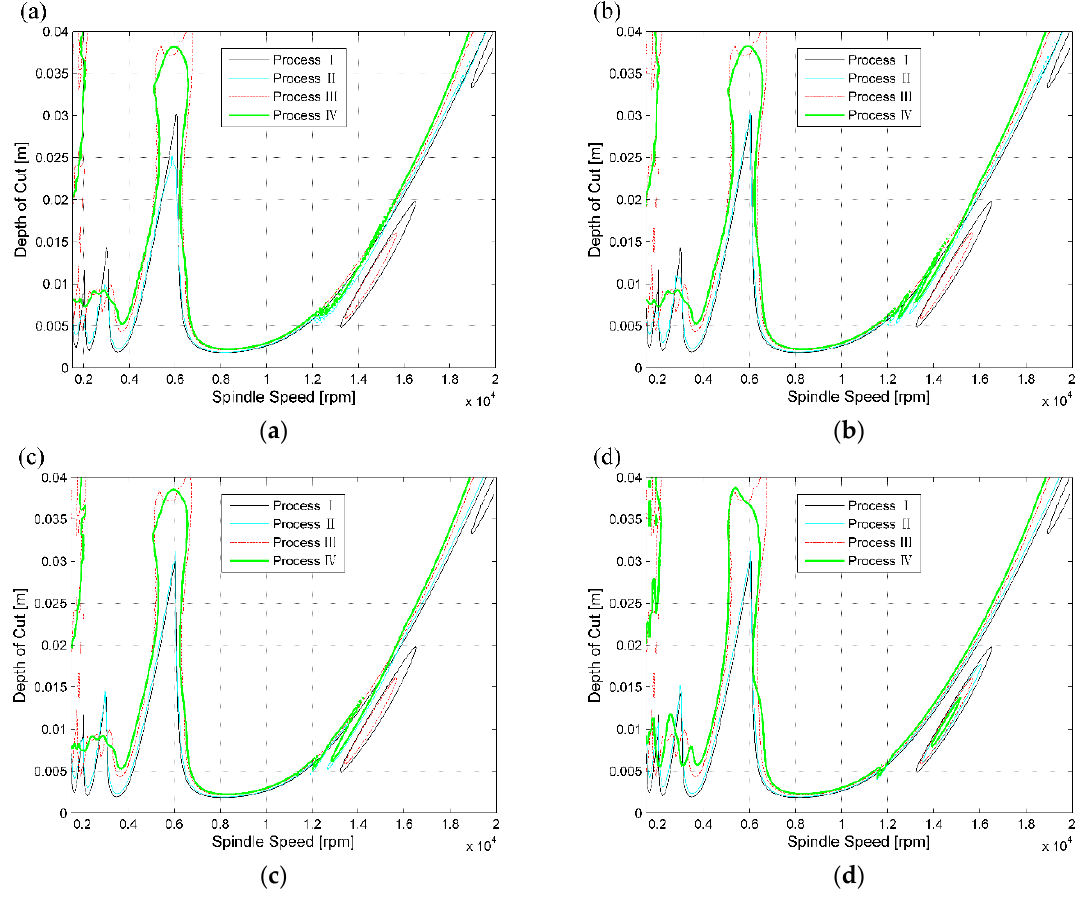
Figure 4. Comparisons of the SLDs associated with Processes I, II, III, and IV for the 1-DOF system. Note that the SLDs for Processes II and IV are plotted under the conditions of different RVF: ( a ) RVF = 0.05; ( b ) RVF = 0.1; ( c ) RVF = 0.2; and ( d ) RVF = 0.5.